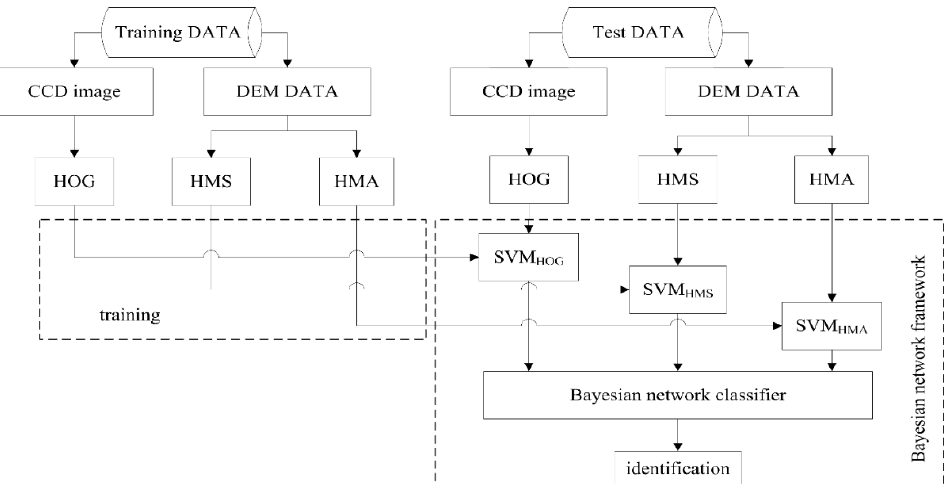
Figure 1 The flow chart of automatic extraction of impact crater by fusing CCD image and DEM data under the Bayesian network framework